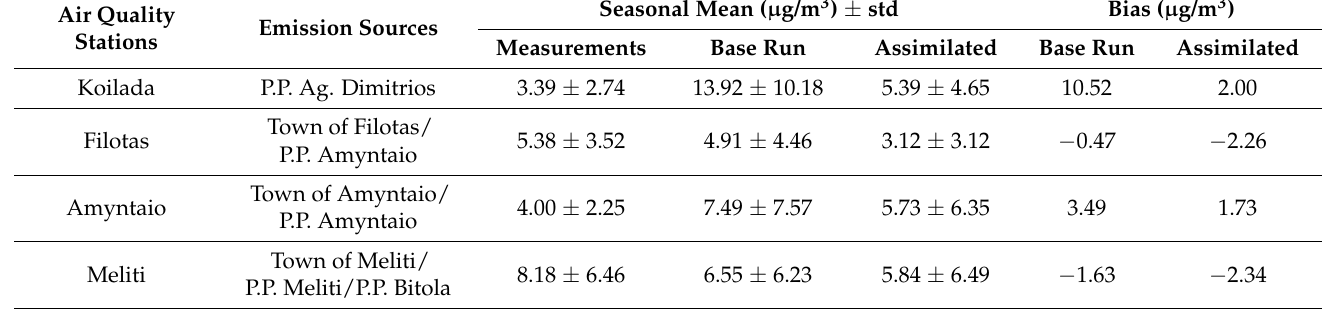
Table 4. Statistics of the comparison of LOTOS-EUROS surface simulations in the base and assimilated runs with surface measurements in the summer of 2019. P.P. refers to power plant.